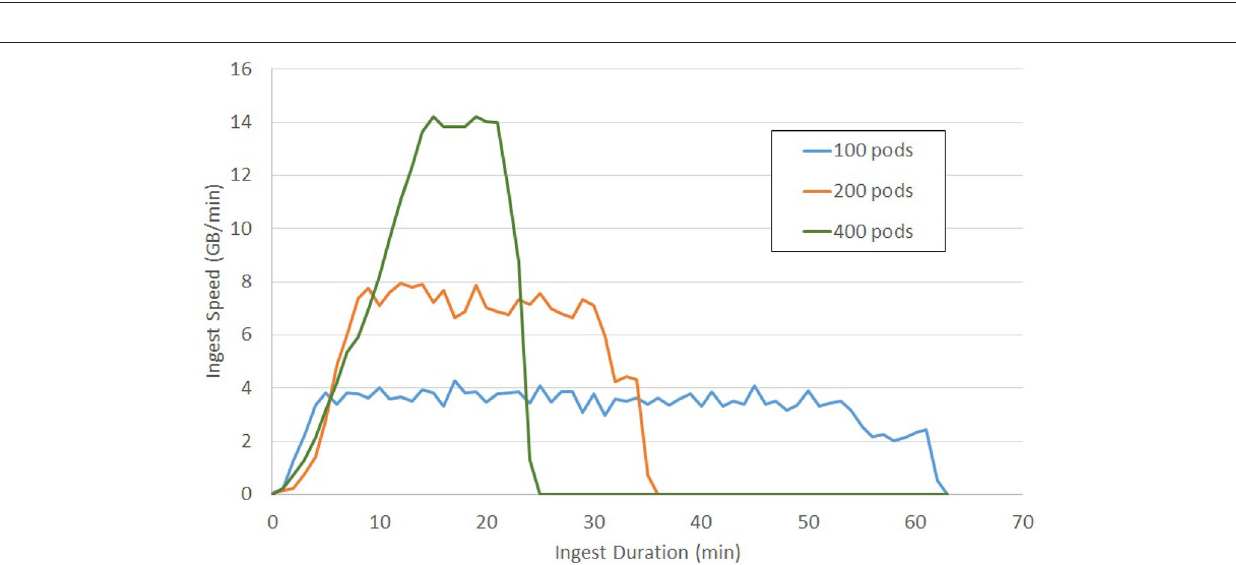
FIGURE 9 | Volumetric Ingest throughput demonstrated over the complete ingest of a 50TB dataset in about 4 h.